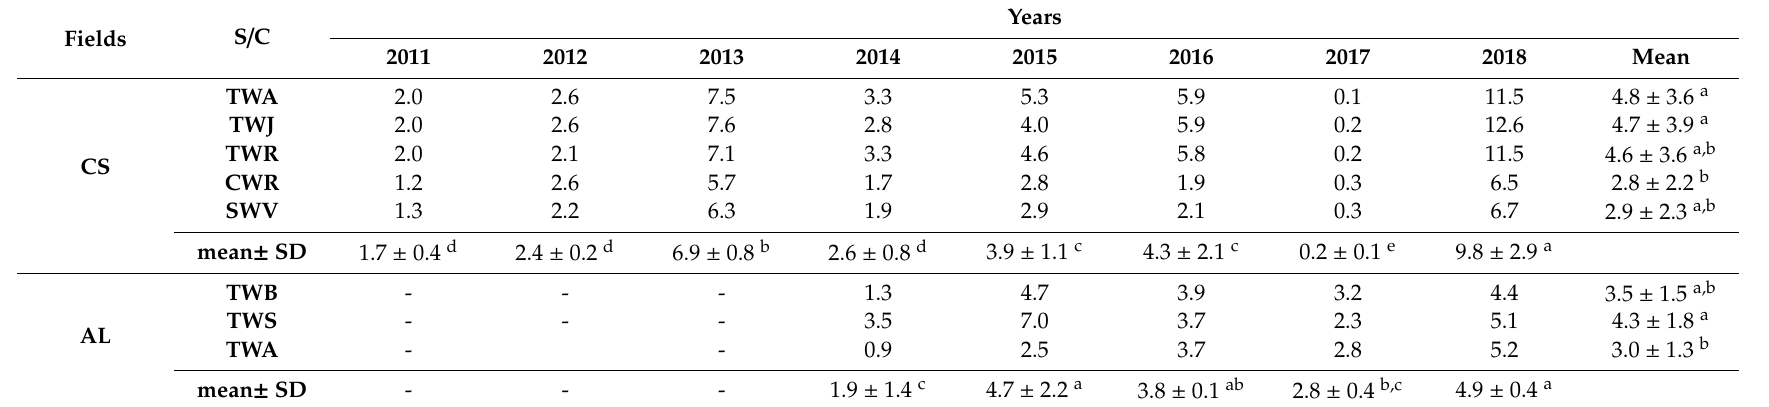
Table 3. Biomass yields from CS and AL stations. Data provided in Mg of dry matter (DM) · ha − 1 . Fields